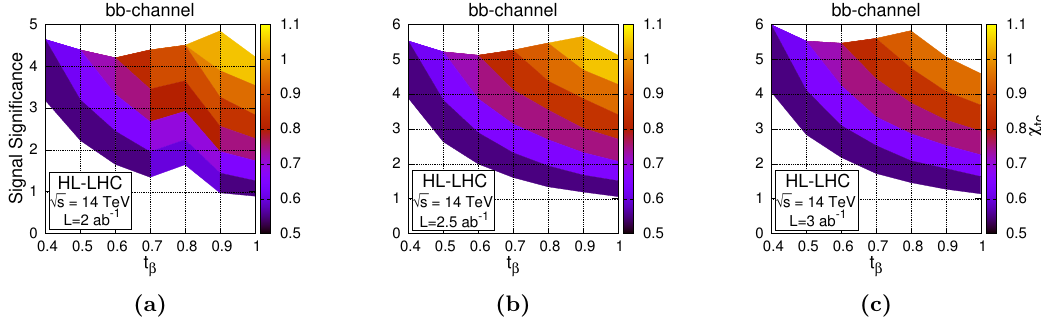
Figure 10. Density plots for the signal signi(cid:12)cance as a function of the t (cid:12) and (cid:31) tc for three illustrative integrated luminosities: (a) L =2 ab (cid:0) 1 , (b) L =2.5 ab (cid:0) 1 , (c) L =3 ab (cid:0) 1 . The case (c) represents the (cid:12)nal integrated luminosity reached by the HL-LHC.